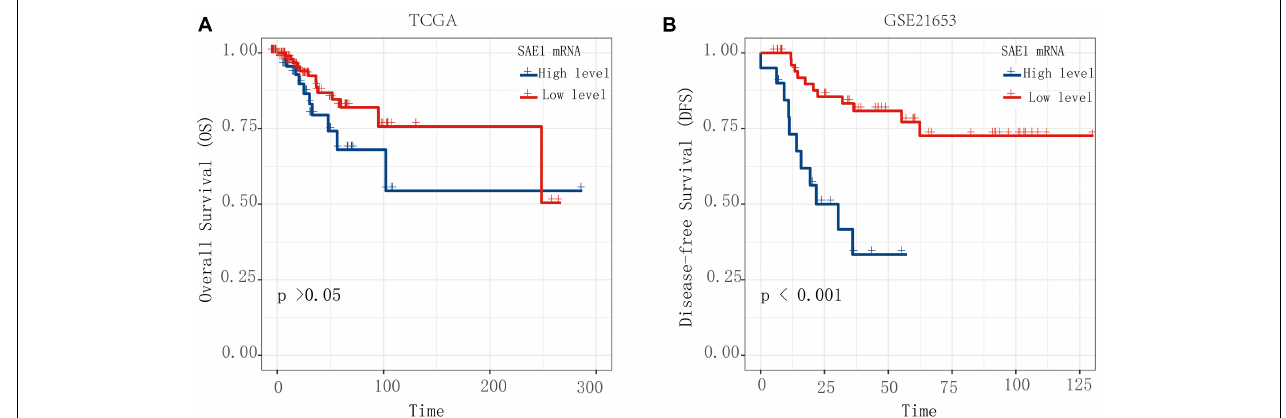
FIGURE 2 | The OS and DFS of SAE1 for TNBC patients. The prognostic value of SAE1 mRNA expression for OS (A) and DFS (B) in TNBC patients by Kaplan-Meier analysis. The log-rank test was performed to evaluate survival difference with the best cutoff value.